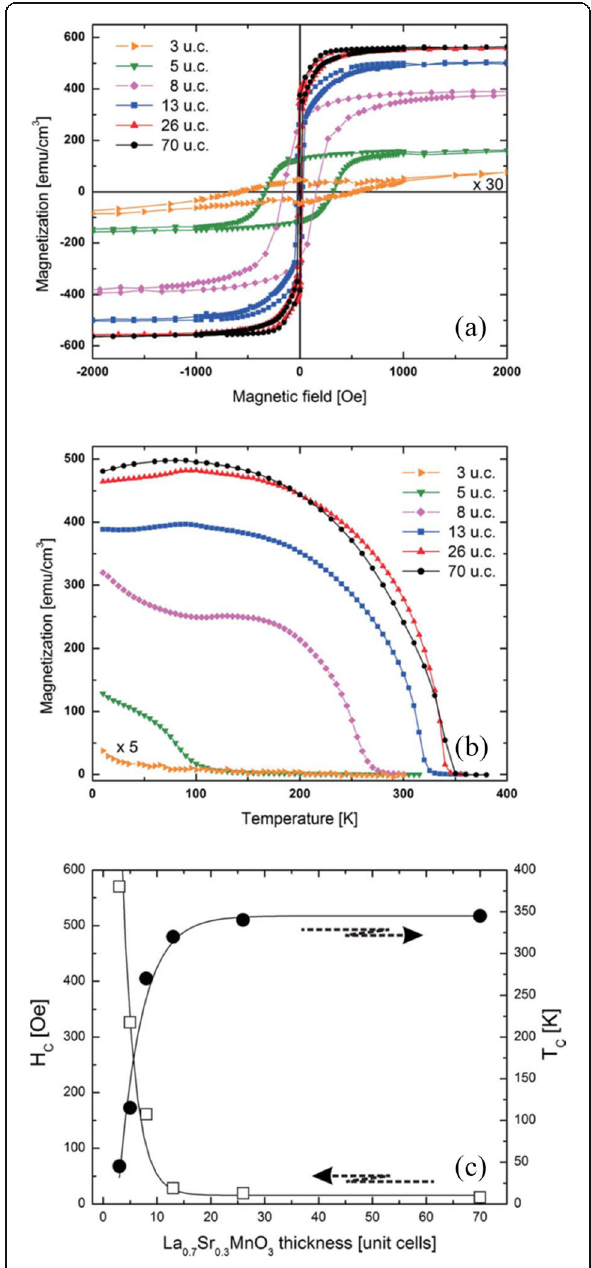
Fig. 34 Ferromagnetic properties of ultrathin La 0.7 Sr 0.3 MnO 3 films on SrTiO 3 (001). a Magnetic hysteresis loops measured at 10 K. The diamagnetic contribution to magnetization not shown has been attributed to the substrate and has been subtracted. b Temperature dependence of the magnetization measured at 100 Oe. All samples were field cooled at 1 T from 360 K along the [100] direction before the measurements were performed. c Layer thickness dependence on the coercive field H C and the Curie temperature T C . Reproduced with permission of